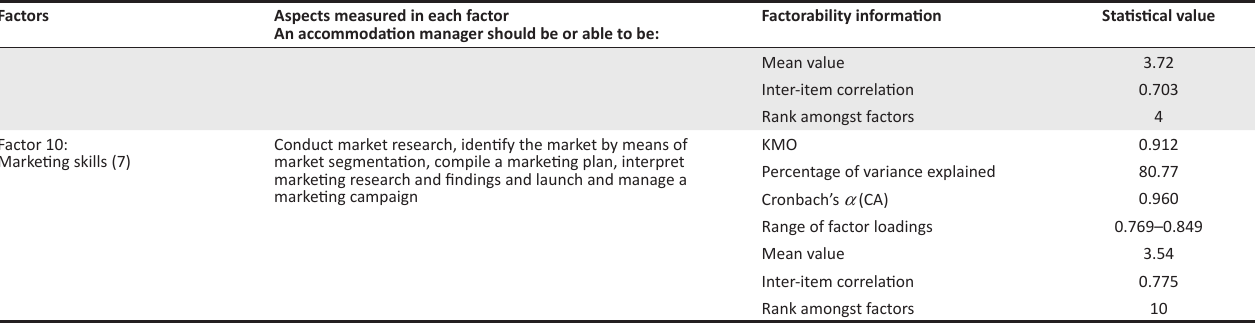
TABLE 4 (Continues...): Summative results of the exploratory factor analyses.